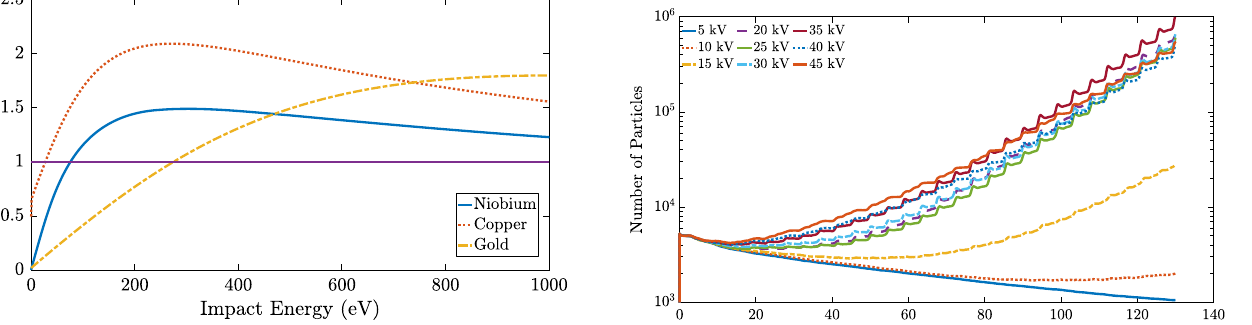
FIG. 3. Secondary emission yield as a function of primary energy of electrons for the materials used in the SRF gun — gold, niobium, and copper.